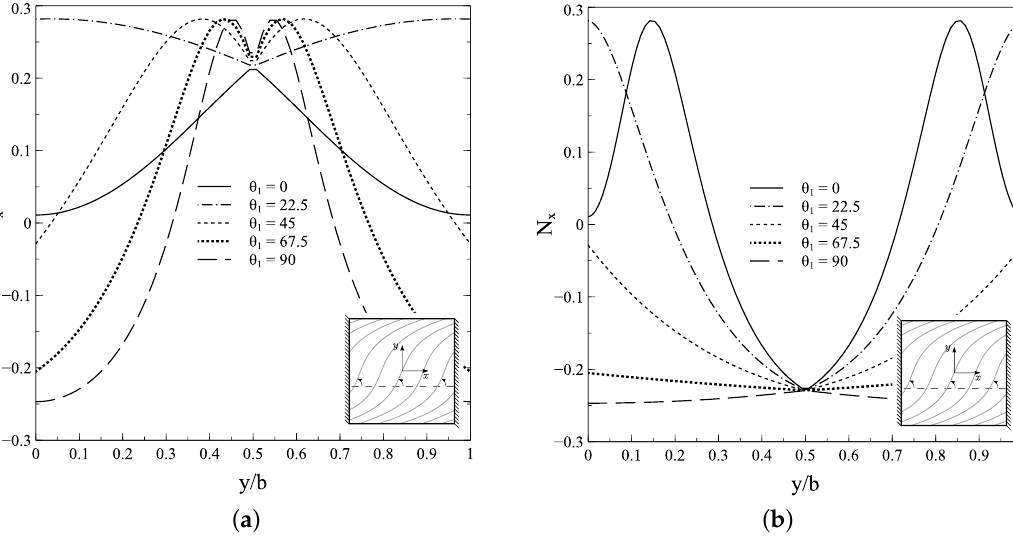
Figure 7. Pre-buckling membrane resultants for [ ± < θ 0 | θ 1 > y ] s laminates subjected to Case-Ty2 conditions: ( a ) θ 0 = 15; ( b ) θ 0 =